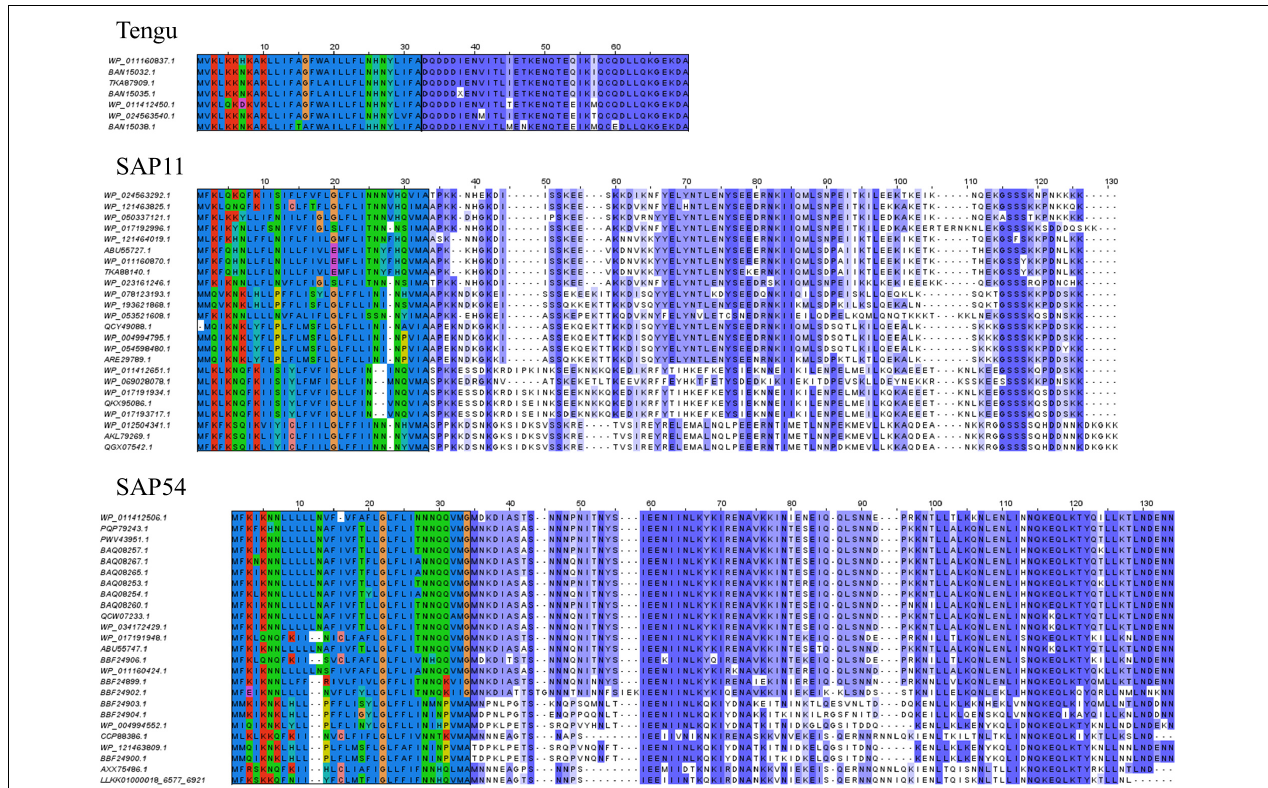
FIGURE 1 | Sequence alignments of the Tengu, SAP11, and SAP54 homologs. The signal peptide regions have been colored according to the biochemical properties of amino acids (red: positively charged residues, blue: hydrophobic residues, green: polar residues, dark pink: negatively charged residues). Mature protein residues have been colored according to amino acid conservation among sequences (violet shades).